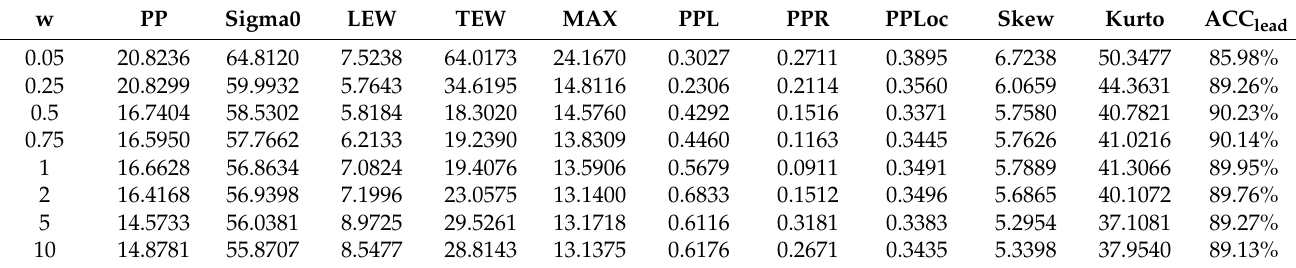
Table 1. The optimized thresholds and their corresponding weight and lead accuracy.